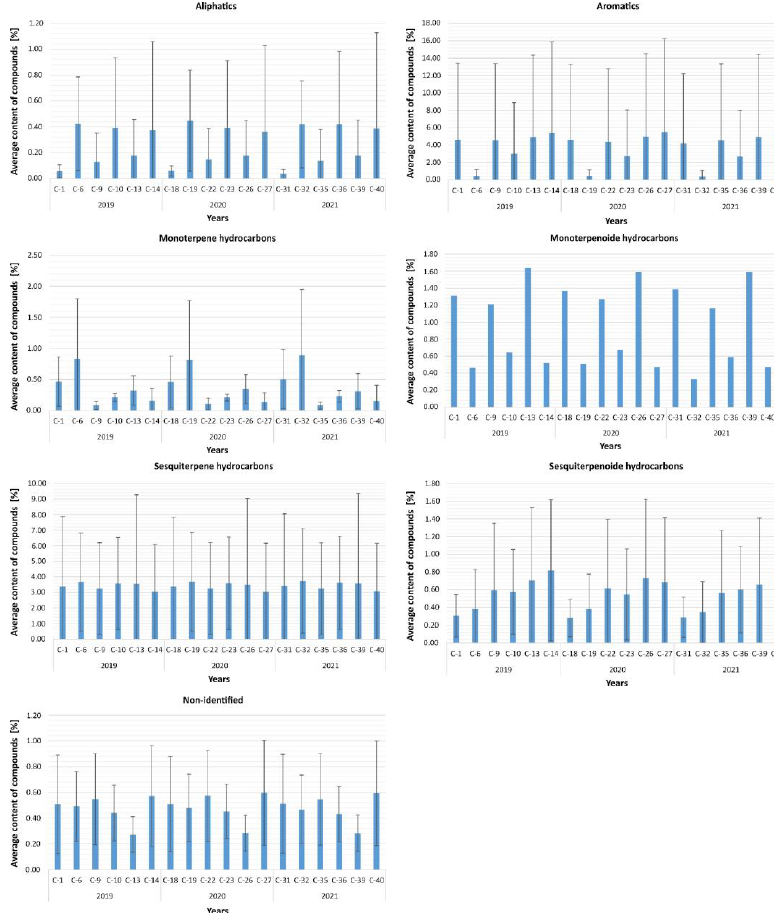
Figure 6. Varying the level of volatile compounds depending on the type of